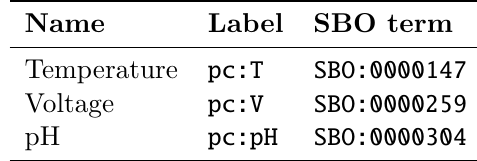
Table 2.5: A sample of values from the physical characteristics vocabulary (Section